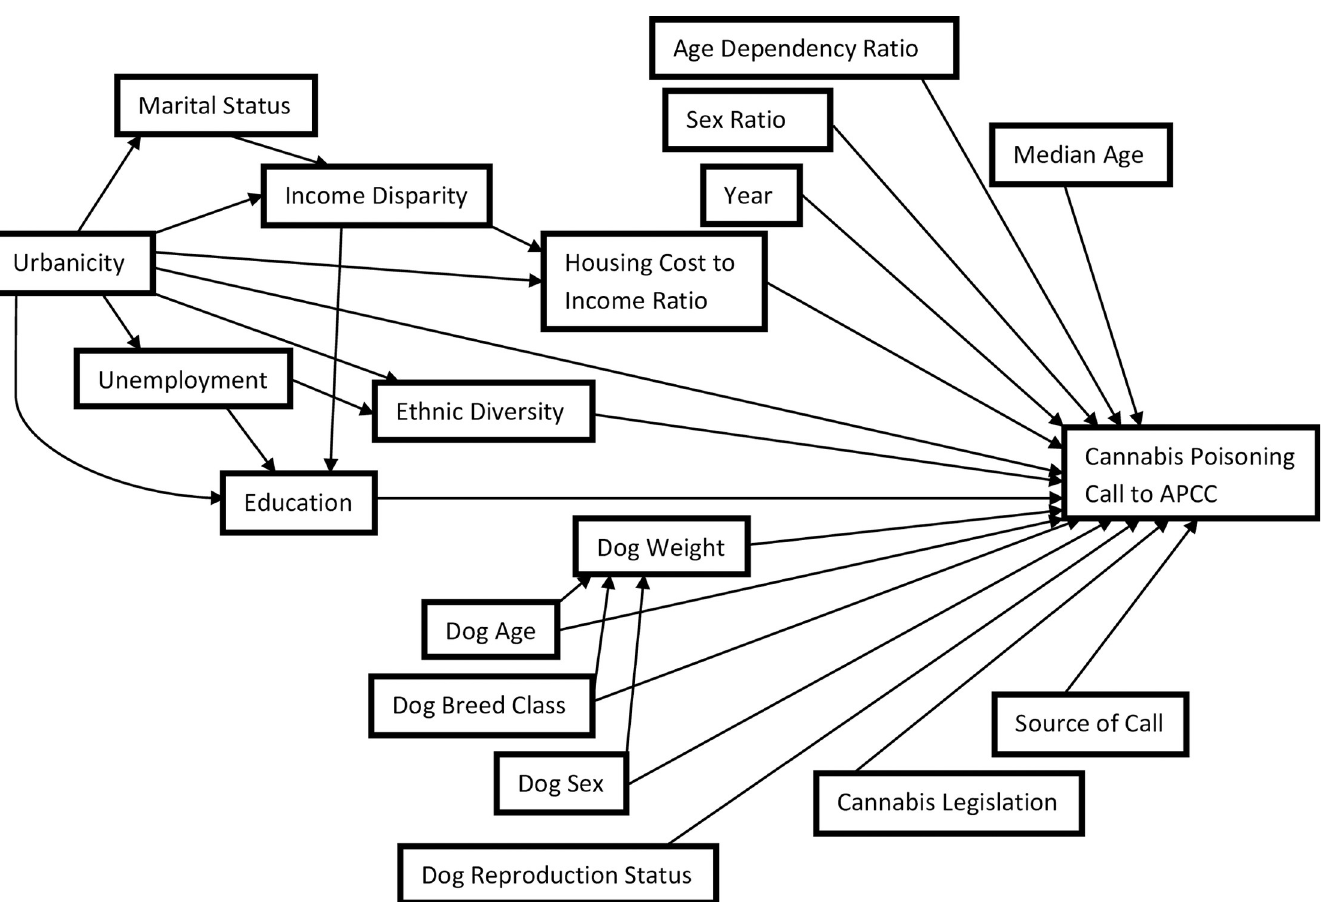
Fig 1. Causal diagram representing the relationship between dog-level and community-level factors and the odds of a call being related to a dog poisoning event from a cannabis product. https://doi.org/10.1371/journal.pone.0250323.g001 There were slightly more female dog related calls than male related calls, with very few calls being made where the sex of the dog was unknown (Table 2). The largest group of dogs were toy and sporting breed classes (i.e., > 20% of dogs) with very little representation from the FSS breed class (Table 2). The majority of calls to the APCC were made by dog owners and most calls concerned neutered dogs (Table 2). Due to the need for subsequent analyses, most vari- ables related to community characteristics were categorized into quantiles (Table 3). In terms Table 1. Descriptive statistics concerning the frequency of calls made on behalf of US dogs to the APCC a for cannabis and non-cannabis poisoning events from each year of the study (2009–2014). Call